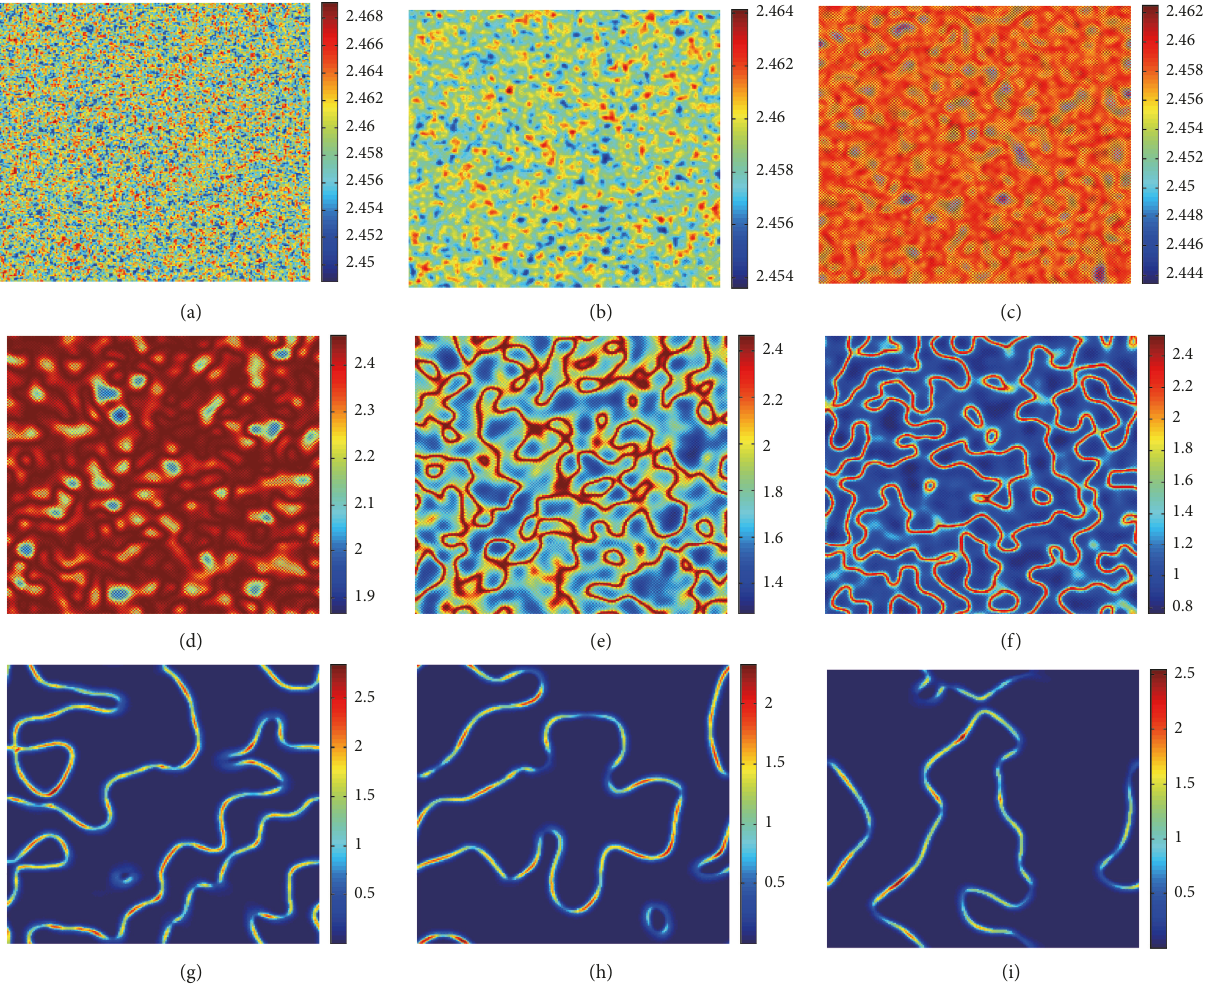
Figure 9: The formation of phytoplankton population spatial distribution pattern under certain parameters. Parameter values: I � 1 . 6, a � 0 . 5, b � 0 . 8, α � 0 . 7, e � 0 . 2, h � 1, m � 0 . 45, d t � 40; (d) t � 50; (e) t � 60; (f) t � 75; (g) t � 250; (h) t � 400; (i) t �